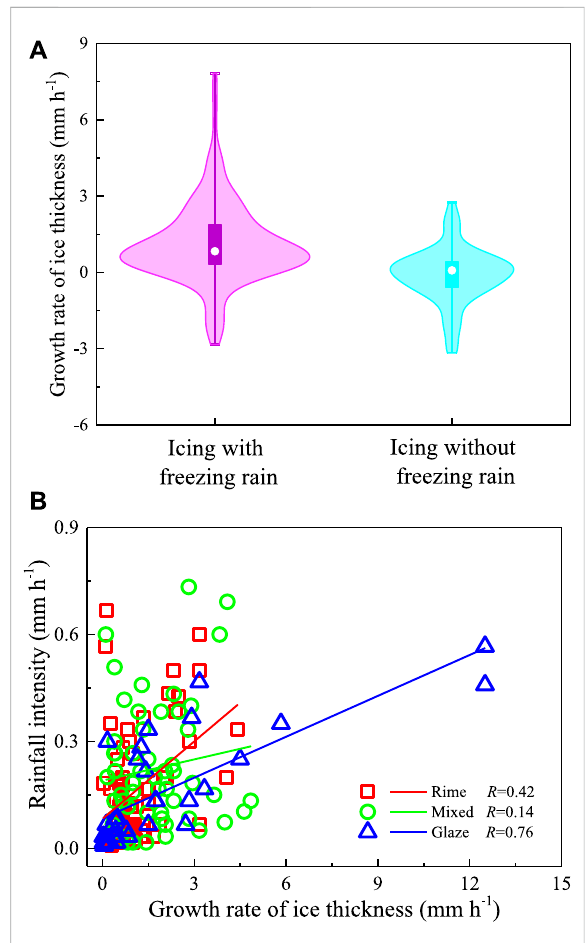
FIGURE 3 Relationship between the FR and growth rate of ice thickness during the 30 ice accretion processes. (A) Violin and box-whisker plots of the growth rate of ice thickness with and without FR. The central box represents the values from the lower to upper quartiles (25th to 75th percentiles), and the vertical line extends from the minimum to the maximum. The middle hollow square represents the mean value. (B) The correlations between the rainfall intensity and growth rate of ice thickness during the rime (red square), glaze (blue triangle), and mixed-phase (green circle) icing